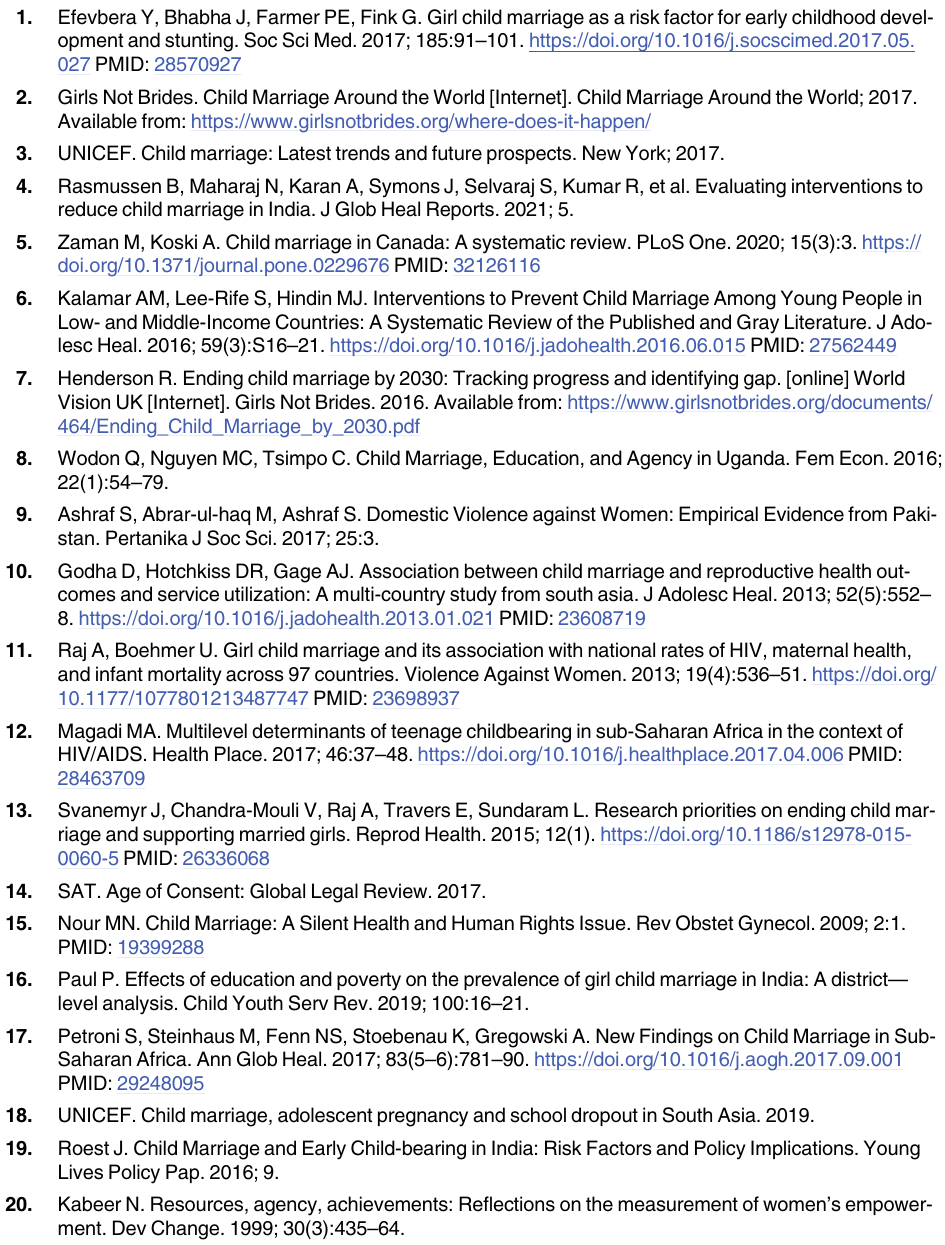
S3 Fig. Summary of methodological quality of longitudinal studies using Joanna Briggs Institute Critical Appraisal